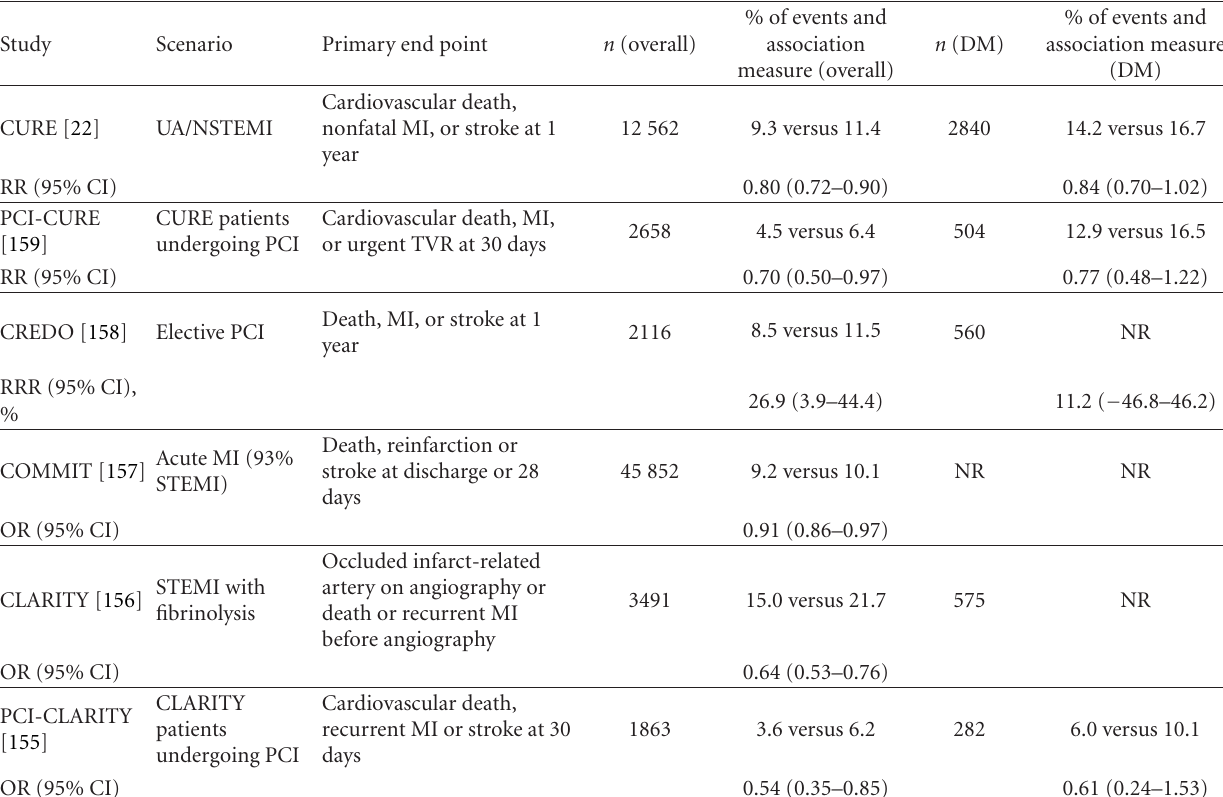
Table 3: Outcomes from large-scale randomised placebo-controlled trials evaluating the e ffi cacy of dual antiplatelet therapy with aspirin and clopidogrel versus aspirin alone in ACS/PCI patients in the overall study population and in DM